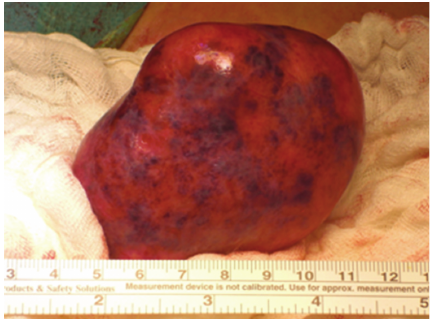
after an ovarial torsion, the operation was interrupted and an ML was planed.